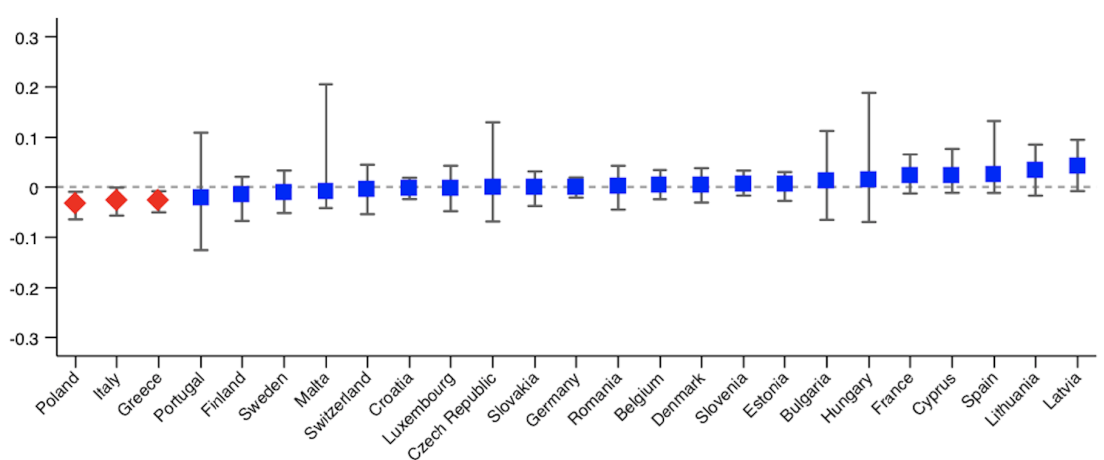
Figure 3. Erreygers’ concentration indices of income-related inequality in denied health care during the COVID-19 pandemic across European countries. Note: red diamonds indicate p < 0.05.